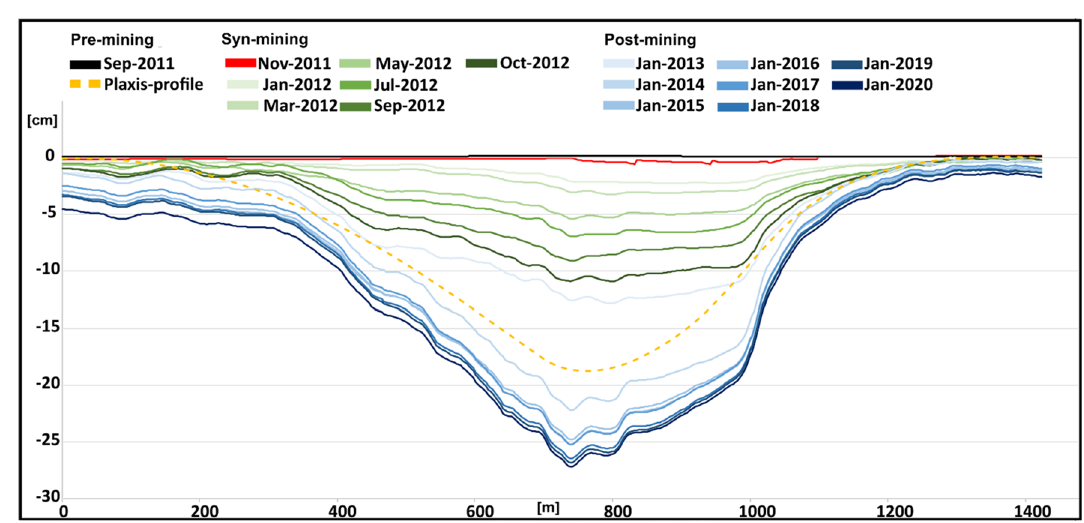
Fig. 10 Cumulated vertical deformation profiles during the pre-mining, syn-mining, and post-mining activity. Yellow dashed lines in the figure represent the expected subsidence Table 2 Maximum vertical and horizontal displacements related to mining progress. the E-W and W-E were related to the directions of horizontal displacements